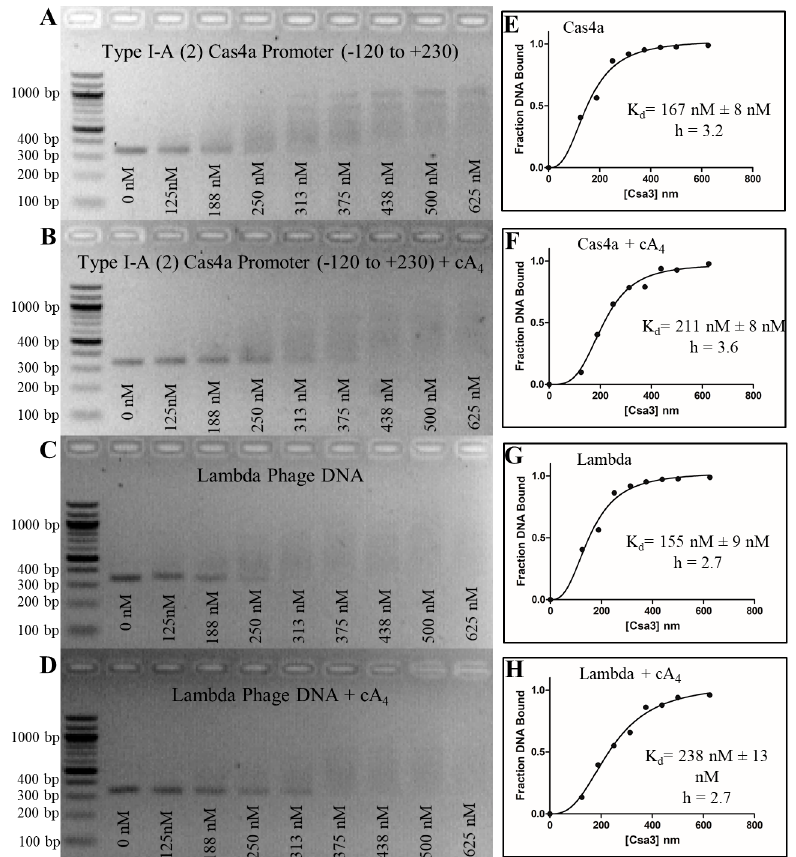
Figure 7. Nonspecific binding to the type I-A (2) cas4a promoter. ( A – D ) Csa3a binds both the cas4a promoter region containing CAPPa and the control Lambda DNA fragments with 150–250 nM affinity, indicating a nonspecific interaction in the absence of cA 4 . The addition of cA 4 does not affect binding affinity or specificity. EMSA experiments were performed with 18 nM DNA and increasing [Csa3] dimer (denoted below the lanes). ( E – H ) Graphs generated in GraphPad Prism display curves for specific binding with a Hill coefficient (h) fit to binding data generated using ImageJ image analysis software. EMSA fragments are detailed in Table S4.